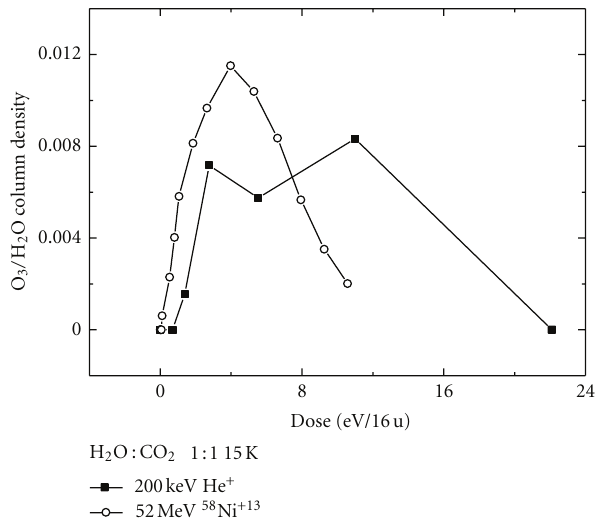
Figure 5: The column density ratio (O 3 /H 2 O) of a mixture H 2 O:CO 2 = 1:1 are shown versus the dose adsorbed by irradiation with 200 keV He + or 52 MeV Ni +13 at 15K.